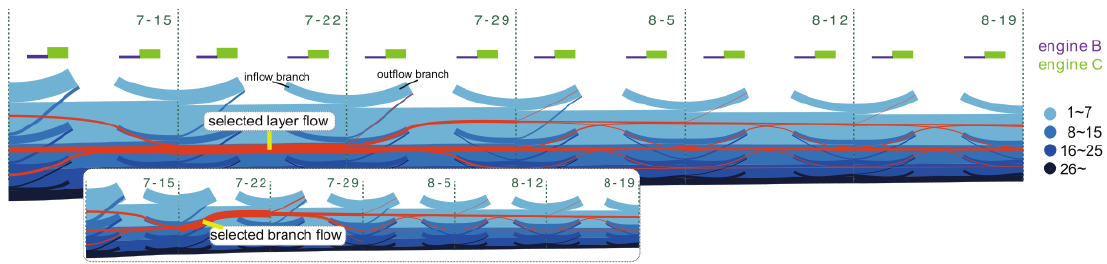
Figure 22. The Flow View of the LoyalTracker software. The depth of each layer represents the level of loyalty the users portray. Curved lines are used to convey the inflow and outflow of customers for each loyalty layer. The flow shows a weeks worth of data for each cycle in the visual design. Image courtesy of Shi et al.